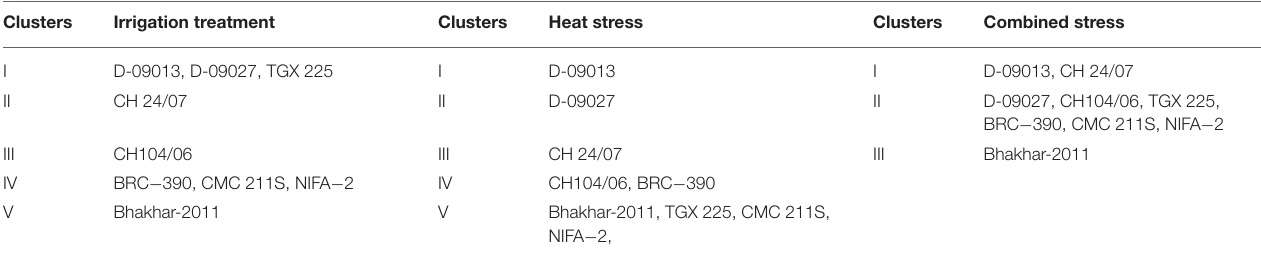
TABLE 3 | Classification of chickpea genotypes in different clusters based on morphophysiological and biochemical traits under irrigation, heat, and combined stress treatments.